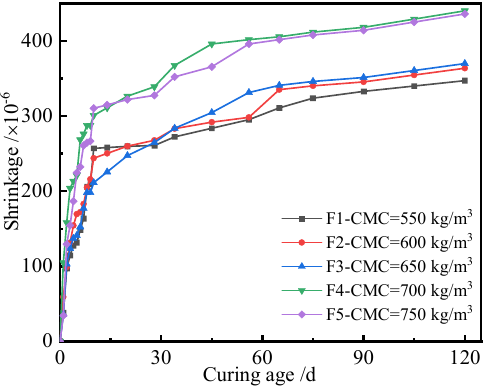
Figure 7. Shrinkage curves of the UHPC with curing age.